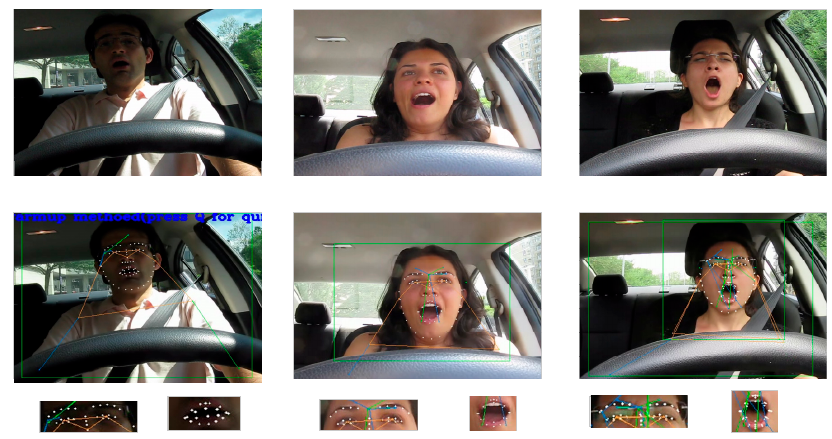
Figure 9. Face localization, key point detection, and detection of the eyes and mouth.